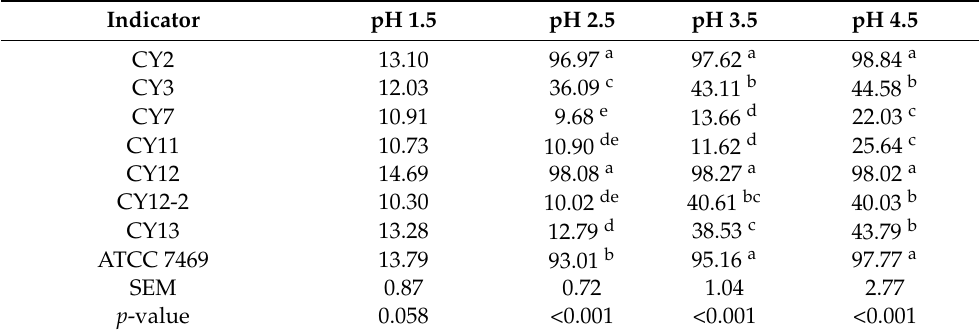
Table 2. Effect of pH on viability of Lactobacillus